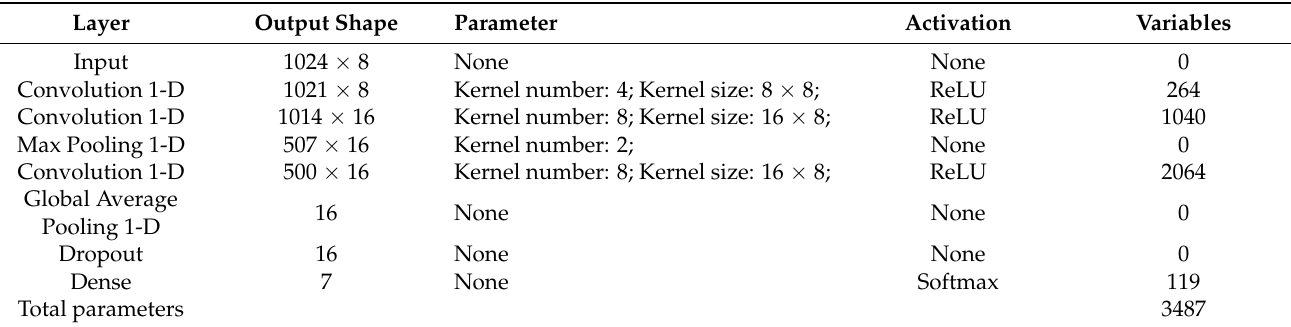
Table 2. Configuration of the 1D-CNN used in this